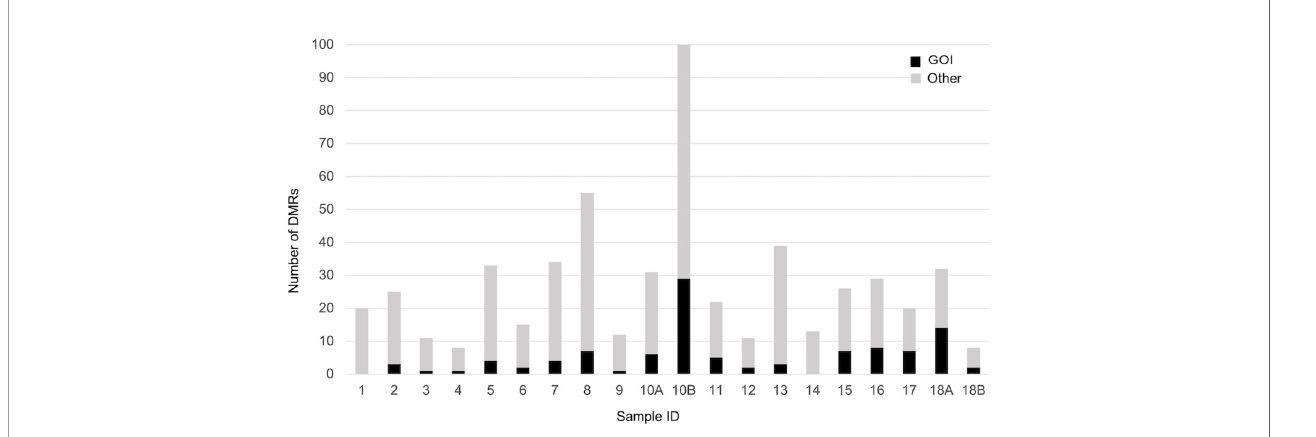
FIGURE 4 | Number of signi fi cant DMRs (adjusted p-value < 0,05), close to GOI (black) and to different genes (gray), identi fi ed comparing each malformed case with controls.